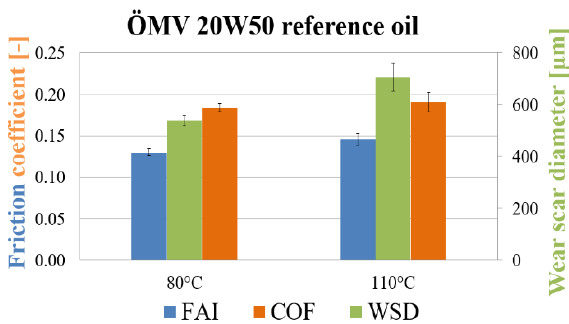
Figure 5. The results of the tribological investigations with the ÖMV 20W50 engine oil used as a reference oil sample (figure of the